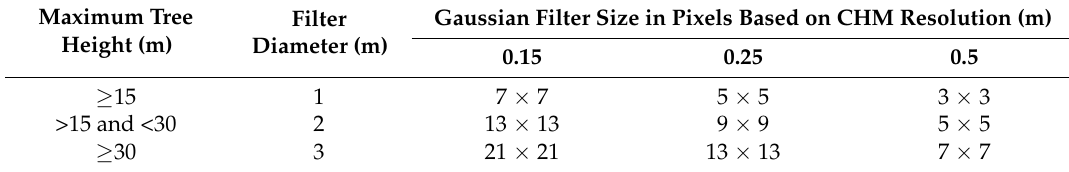
Table 3. Gaussian and local maxima filter